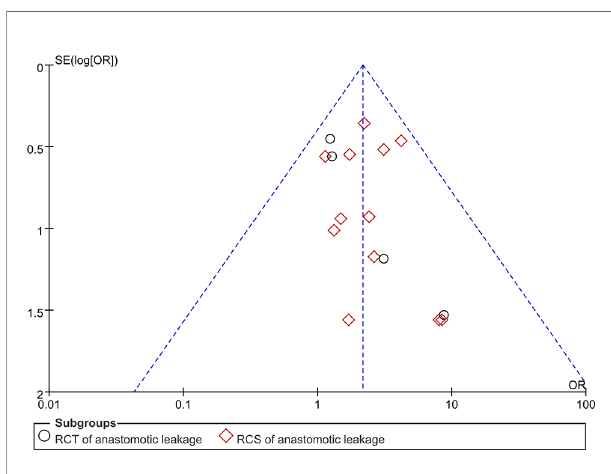
FIGURE 7 | Funnel plot of anastomotic